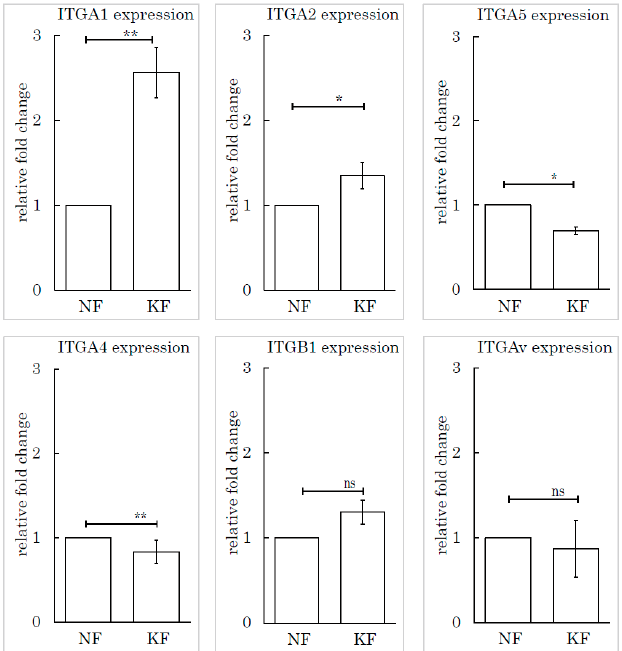
Figure 6. The integrin α 1 expression level in KFs was high relative to NFs. Real-time PCR was